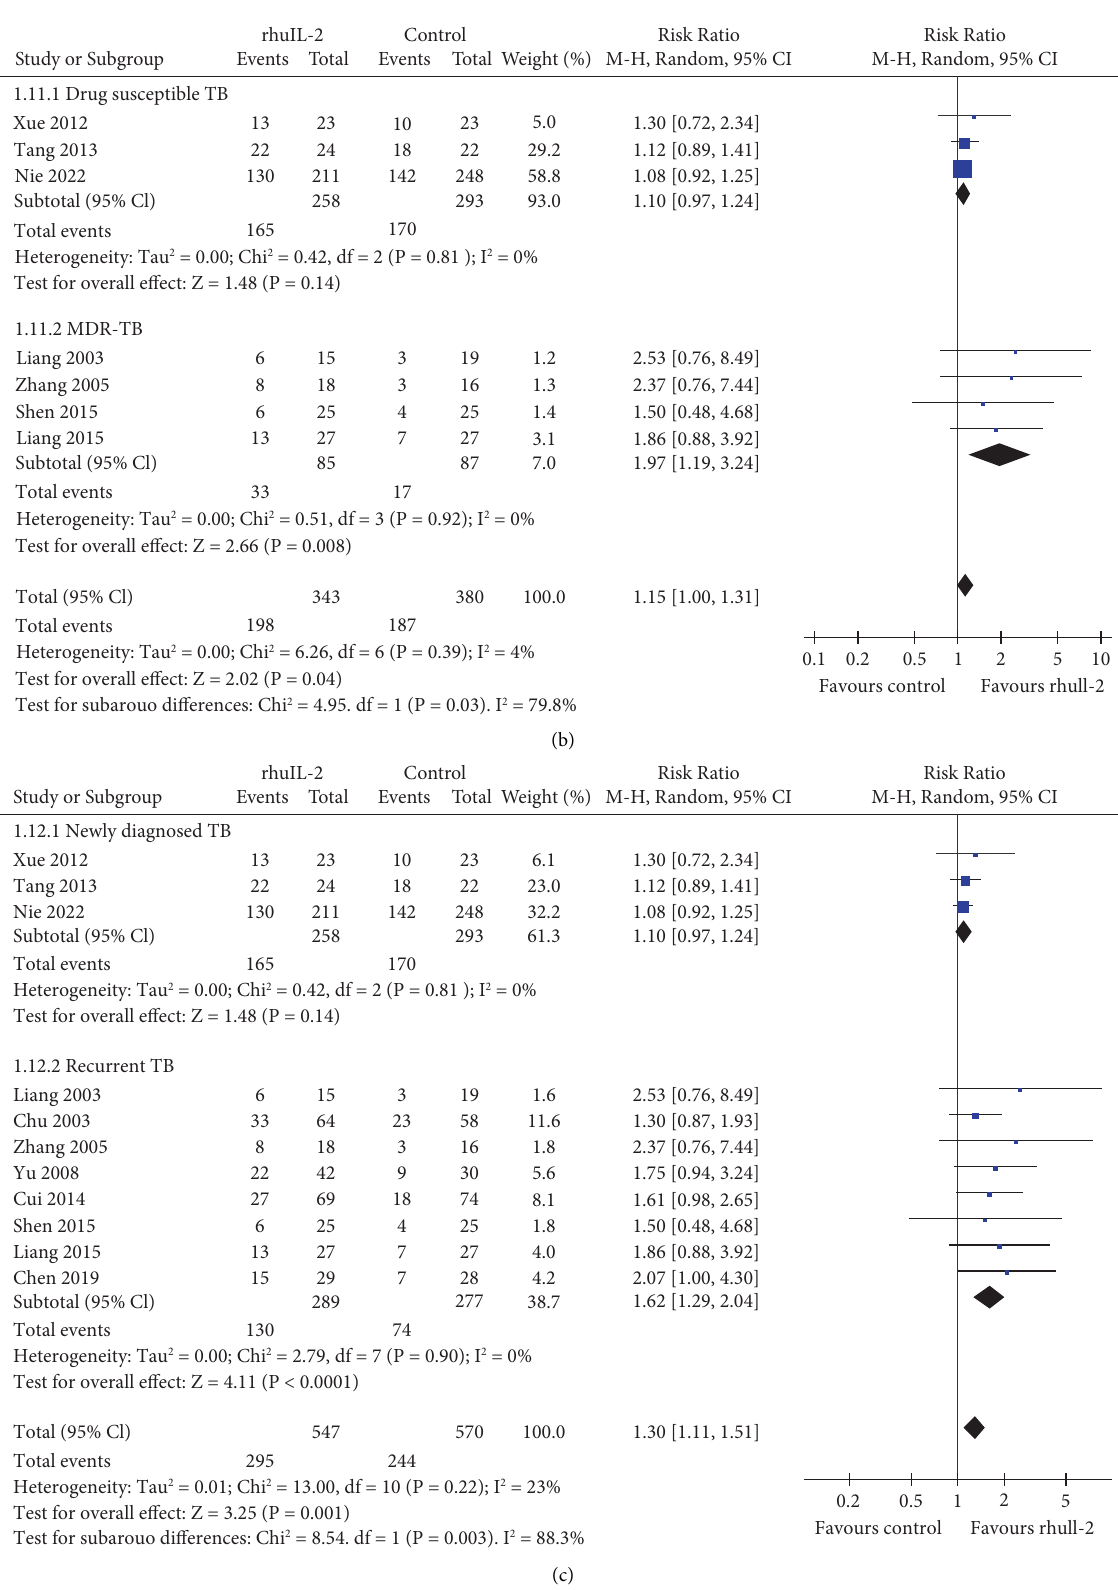
Figure 5: Forest plots for the meta-analysis of the efect of rhuIL-2 on the proportion of patients with radiographic cavity closure; (a), forest plots for the overall meta-analysis; (b), forest plots for the subgroup analysis according to the drug sensitivity of TB; and (c), forest plots for the subgroup analysis in newly diagnosed and recurrent